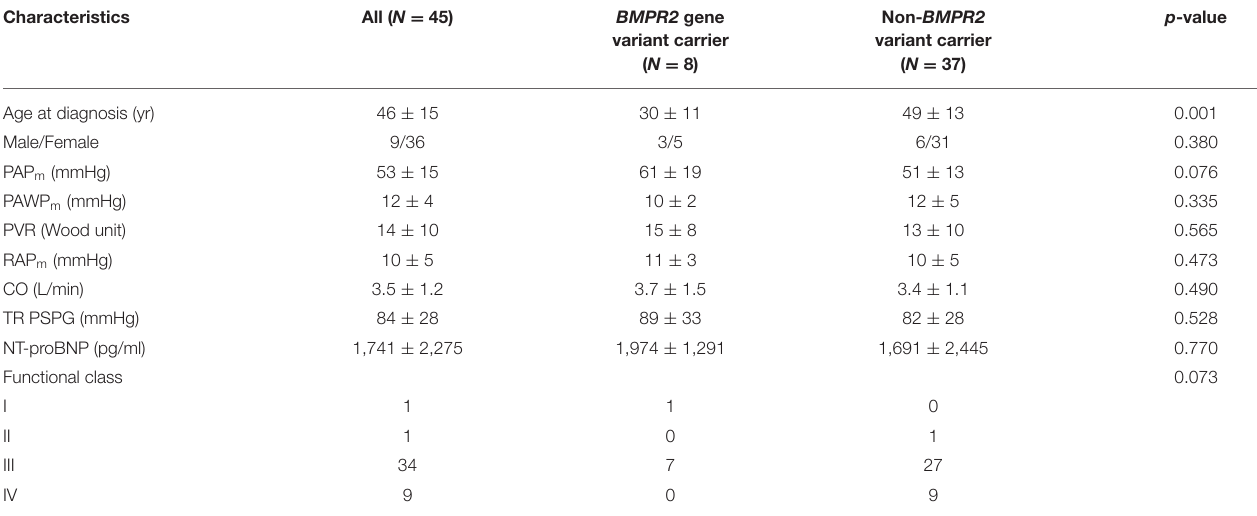
BMPR2, bone morphogenetic protein receptor 2; CO, cardiac output (L/min); NT-proBNP, N-terminal pro-B type natriuretic peptide; PAP m , mean pulmonary arterial pressure (mmHg); PVR, pulmonary vascular resistance (Wood unit); PAWP m , mean pulmonary arterial wedge pressure (mmHg); RAP m , mean right atrial pressure (mmHg); TR PSPG, echocardiographic derived tricuspid valve regurgitation peak systolic pressure gradient.